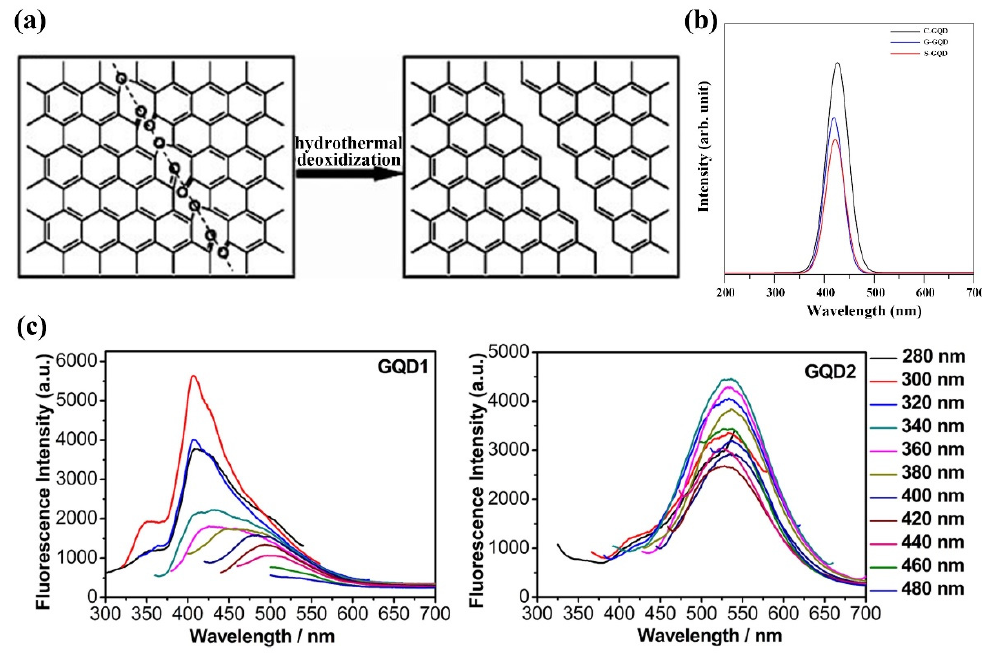
Figure 6. ( a ) Mechanism for the hydrothermal cutting of oxidized GSs into GQDs. Reprinted with